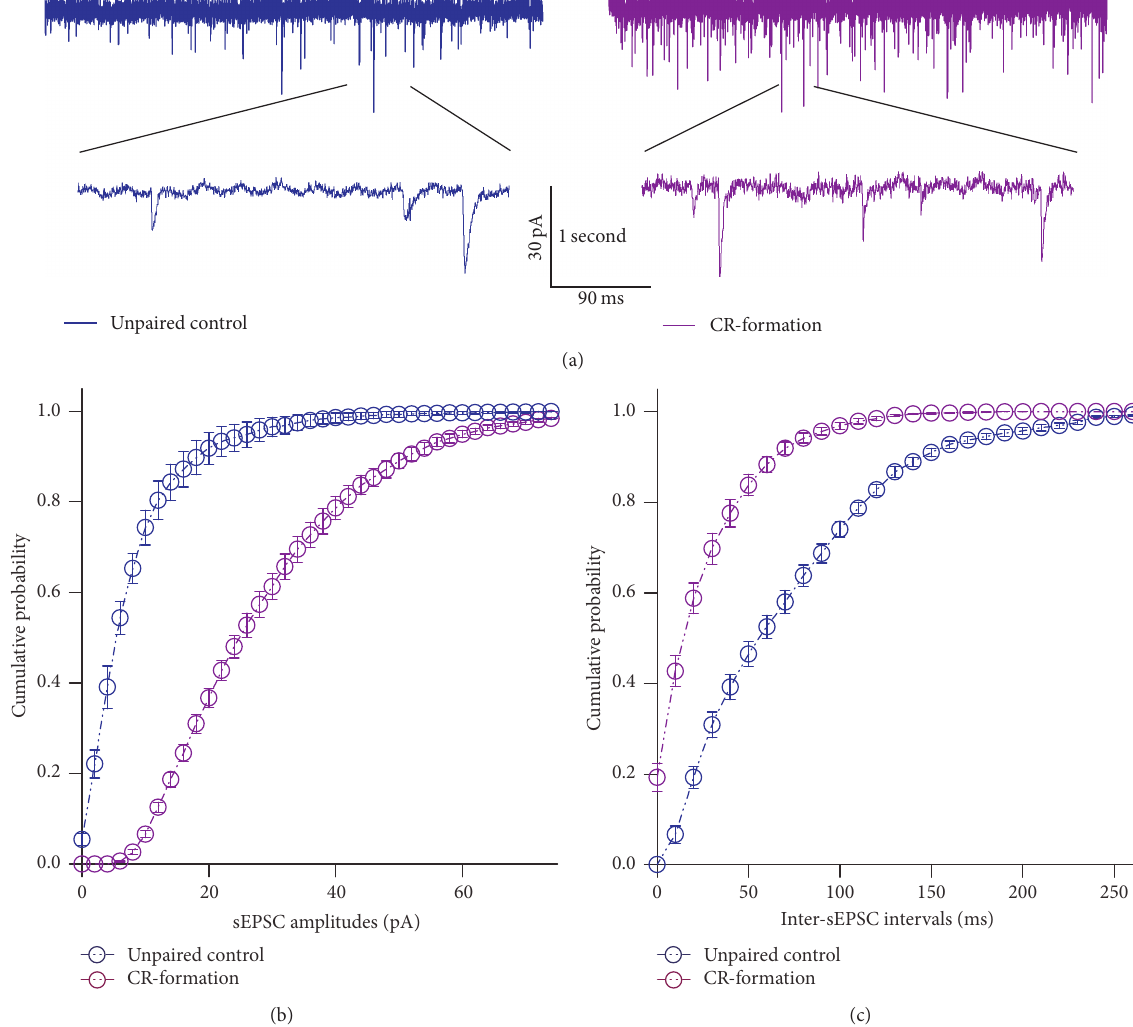
Figure 7: Excitatory synaptic transmission on barrel cortical GABAergic neurons increases after pairing WS and OS. Spontaneous excitatory postsynaptic currents (sEPSCs) were recorded on the GFP-labeled GABAergic neurons in cortical slices under voltage-clamp (holding potential at − 65 mV) in presence of 10 𝜇 M bicuculline. (a) shows sEPSCs recorded on the neurons from controls (dark-blue in left panel) and CR-formation (dark-red in right). The bottom traces are the expanded waveforms selected from top traces. Calibration bars are 30pA, 1 second (top) and 90ms (bottom). (b) shows cumulative probability versus sEPSC amplitudes from control (dark-blue symbols, 𝑛 = 12 ) and CR-formation (dark-red, 𝑛 = 12 ). (c) shows cumulative probability versus inter-sEPSC intervals from controls (dark-blue symbols, 𝑛 = 12 ) and CR-formation (dark-red symbols, 𝑛 = 12